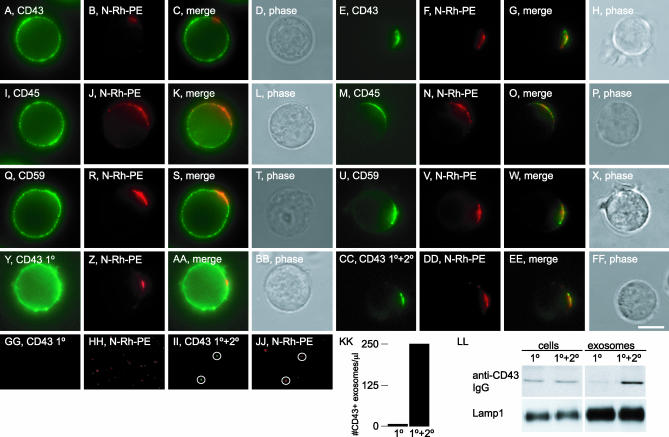
Higher-Order Oligomerization Targets Proteins to ELDs(A–X) N-Rh-PE–labeled Jurkat T cells were incubated with monoclonal antibodies specific for (A–H) CD43, (I–P) CD45, or (Q–X) CD59 and FITC-labeled polyclonal anti-mouse antibodies, on ice, and then either (A–D, I–L, and Q–T) fixed or (E–H, M–P, and U–X) incubated at 37 °C for 2 h and then fixed.(Y–LL) Higher-order oligomerization targets CD43 to exosomes. (Y–FF) N-Rh-PE–labeled Jurkat T cells were incubated with FITC-labeled monoclonal antibodies specific for CD43, then incubated with either (Y–BB) buffer alone or (CC–FF) unlabeled polyclonal rabbit anti-mouse IgG antibodies, all on ice. Cells were incubated for 24 h at 37 °C and then examined. (GG–KK) Fluorescence microscopy of exosomes from cells treated with (GG and HH) primary antibodies only or (II and JJ) primary and secondary antibodies. (KK) Numbers of FITC-positive exosomes secreted by cells exposed to (left bar) primary antibodies only or (right bar) primary and secondary antibodies. Bar indicates 10 μm. (LL) Samples from Jurkat cells incubated with either mouse anti-CD43 IgG only (1°) or with mouse anti-CD43 IgG and anti-mouse IgG (1° + 2°) were blotted with anti-mouse antibodies to determine the amount of CD43 secreted on exosomes, and anti-Lamp1 antibodies to determine the level of exosome secretion. Bar indicates 10 μm.